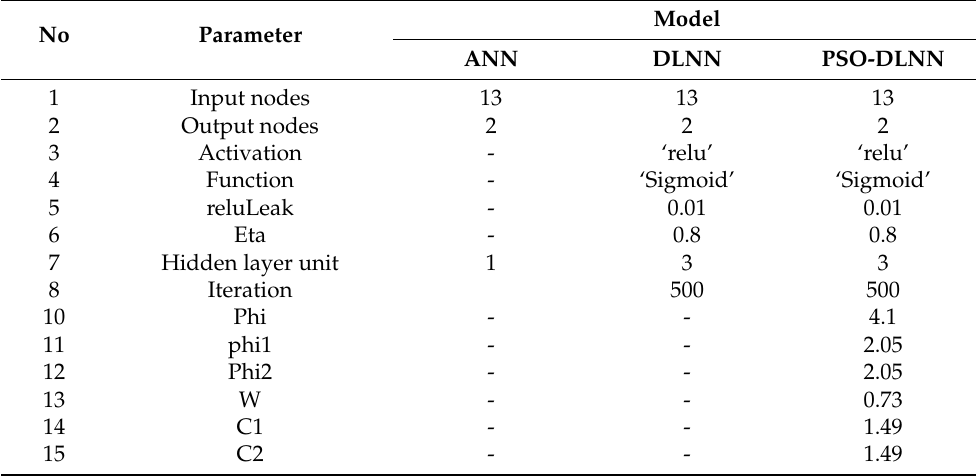
Table 3. Parameters used in ML